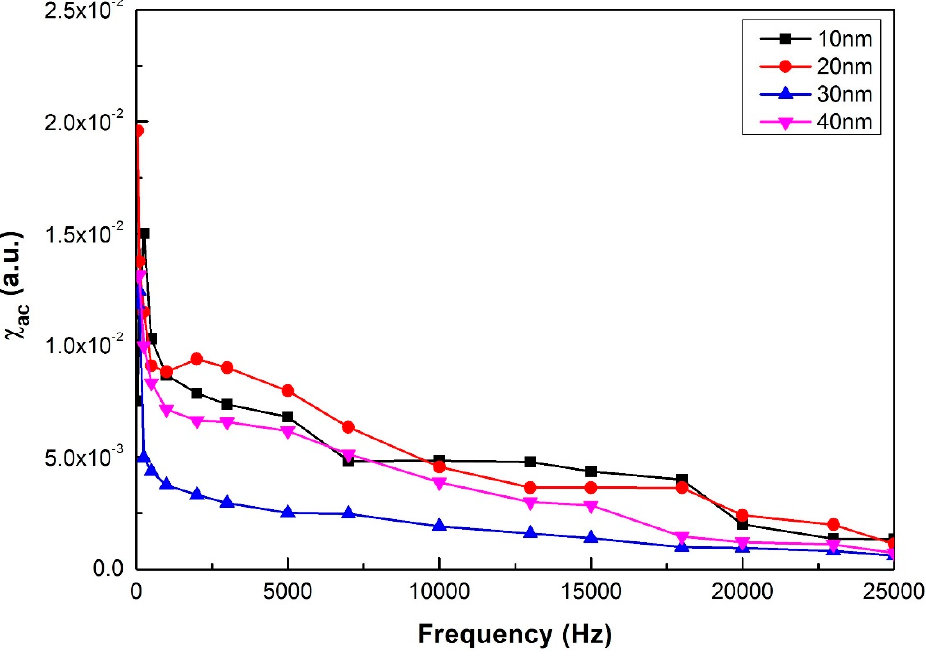
Figure 5. Optimal resonance frequency for films of various thicknesses.